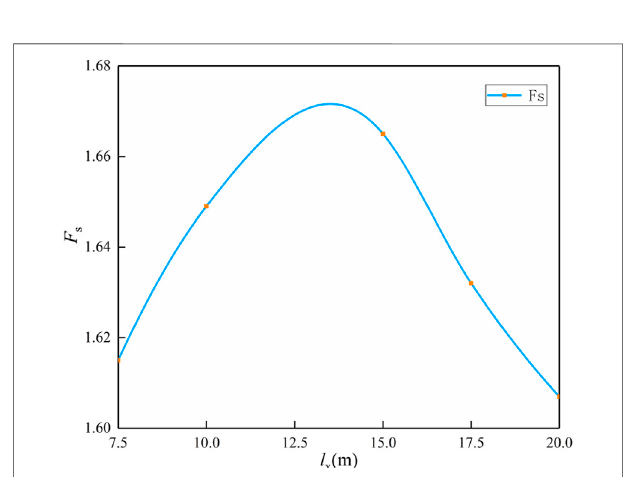
FIGURE 9 | Slope safety factors at different pile locations after